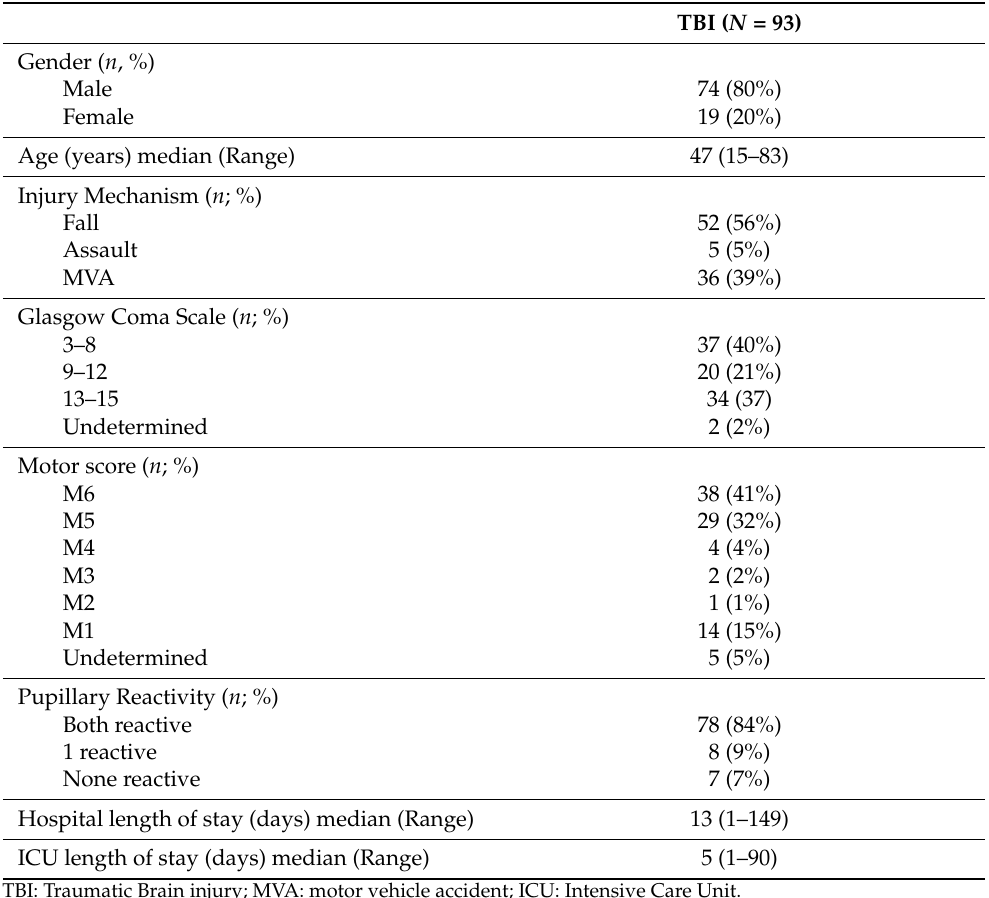
Table 5. Summary of demographic data and clinical characteristics in patients with